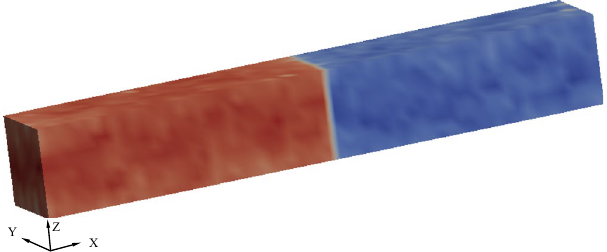
Figure 1. Schematic representation of the uncharged anti-parallel domains. 180° domain wall separating the growing domain and the reversal domain, coloured in red and blue respectively. The domains are anti-parallel in terms of their polarisation